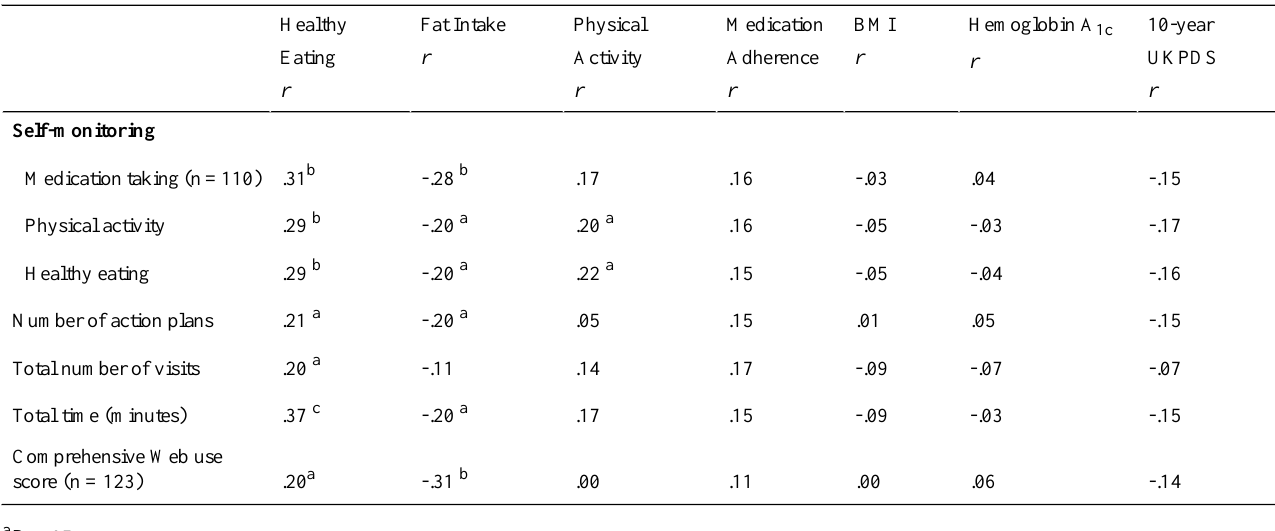
Table 3. Behavioral and clinical correlates of website usage (n = 167 for the 4 behavioral measures; n = approximately 157 for the 3 biological measures; slight variation by measure in that n = 110 for medication because not all on diabetes